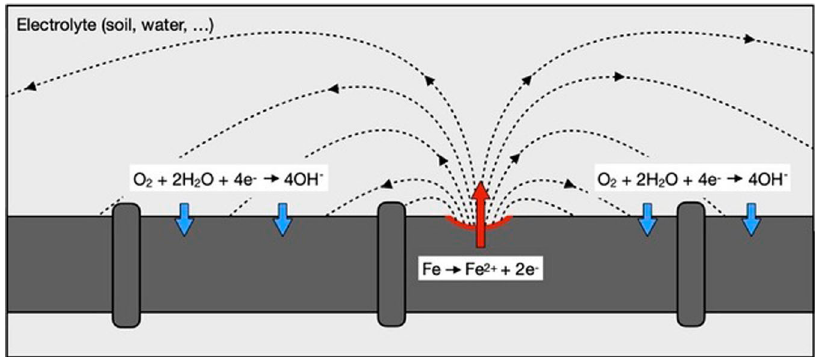
Fig. 8 Macro-cell corrosion and the current lines for the example of a buried pipeline. In red, the actively corroding (anodic)